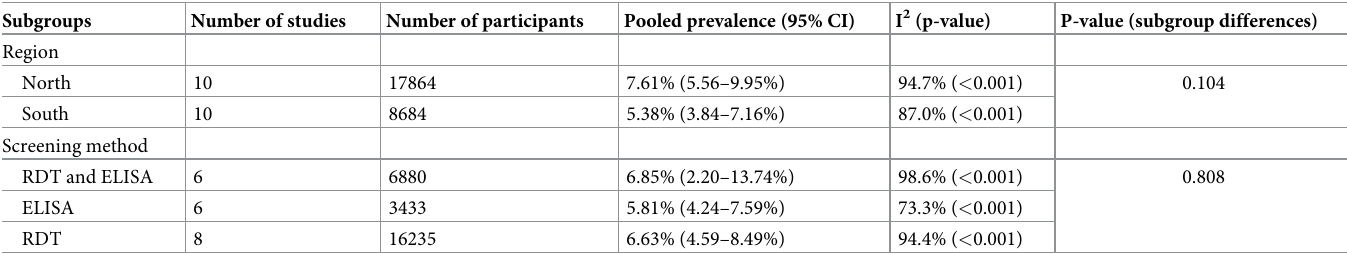
Table 3. Subgroup analysis of HBV prevalence among pregnant women in Nigeria,